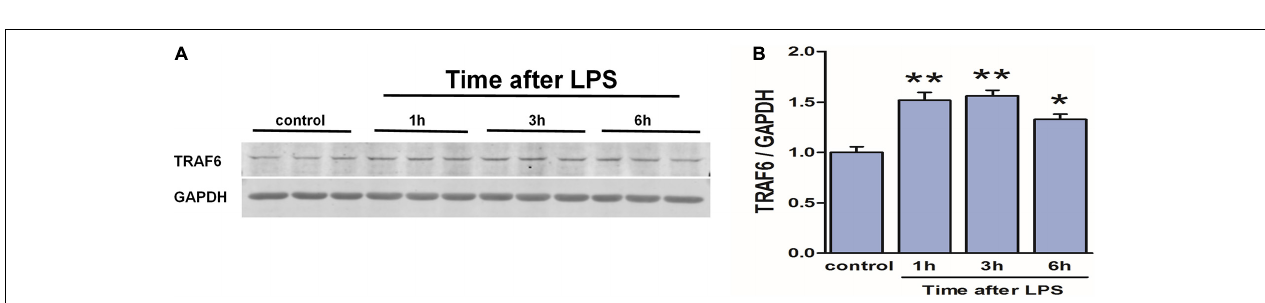
FIGURE 9 | Upregulation of TRAF6 in primary cortical astrocytes in response to LPS. LPS exposure (1 µ g/ml) rapidly upregulated TRAF6 protein expression in cultured primary rat astrocytes. (A) Western blot analysis was used to detect the expression of TRAF6. GAPDH was used as an internal control. (B) The optical density of the bands was analyzed by ImageJ. Values are presented as the mean ± SEM. * P < 0.05 and ** P < 0.01 vs. control group.